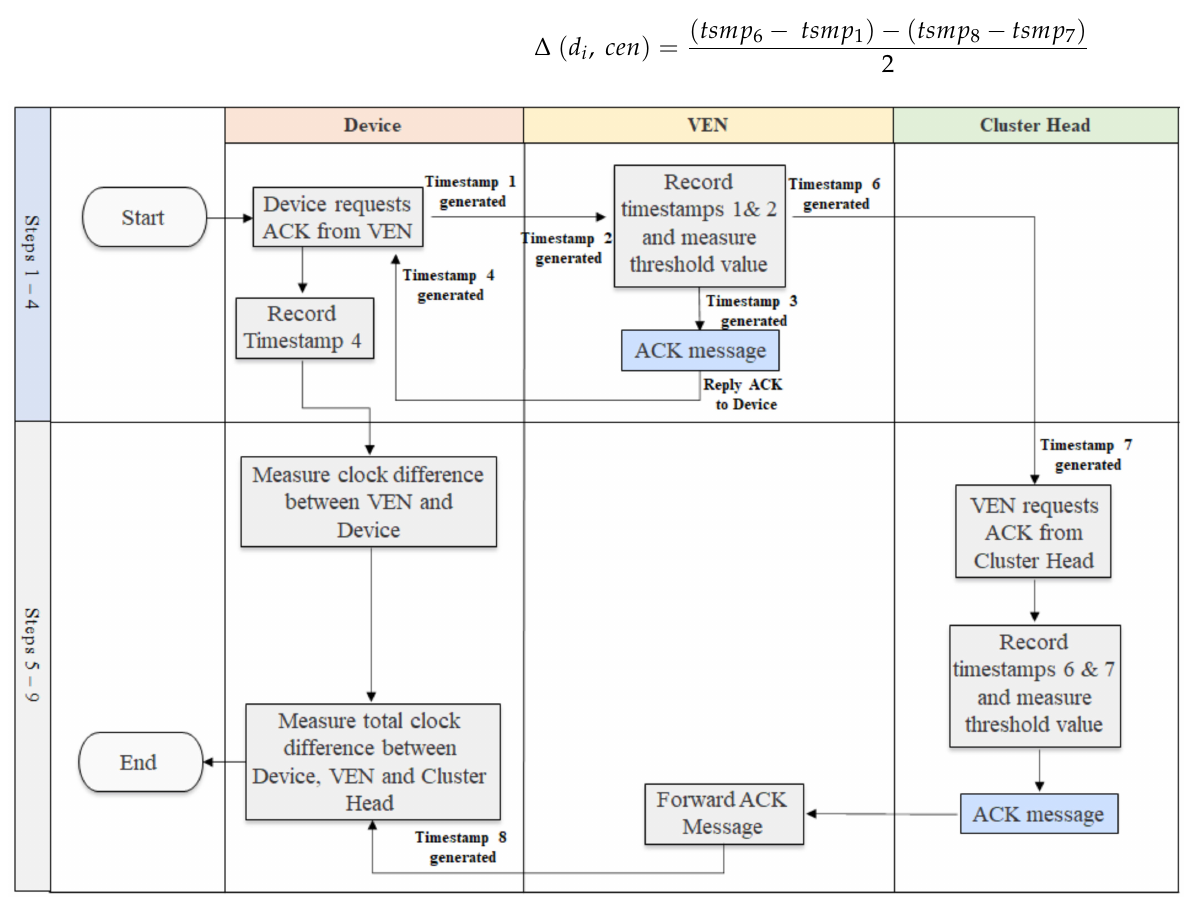
Figure 3. Time synchronization